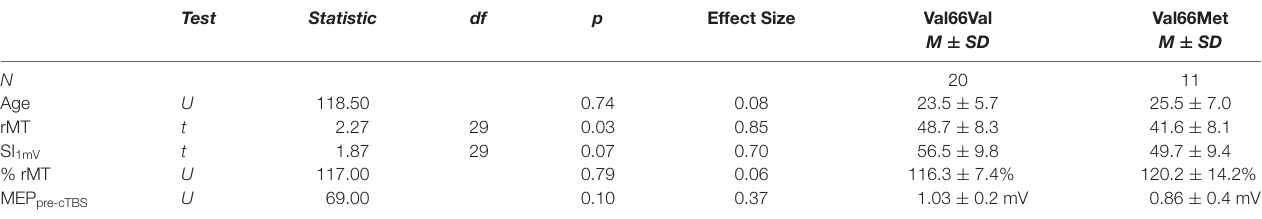
TABLE 1 | Results of the independent-samples t -tests comparing demographic and stimulation parameters for BDNF Val66Val vs. Val66Met allele carriers.